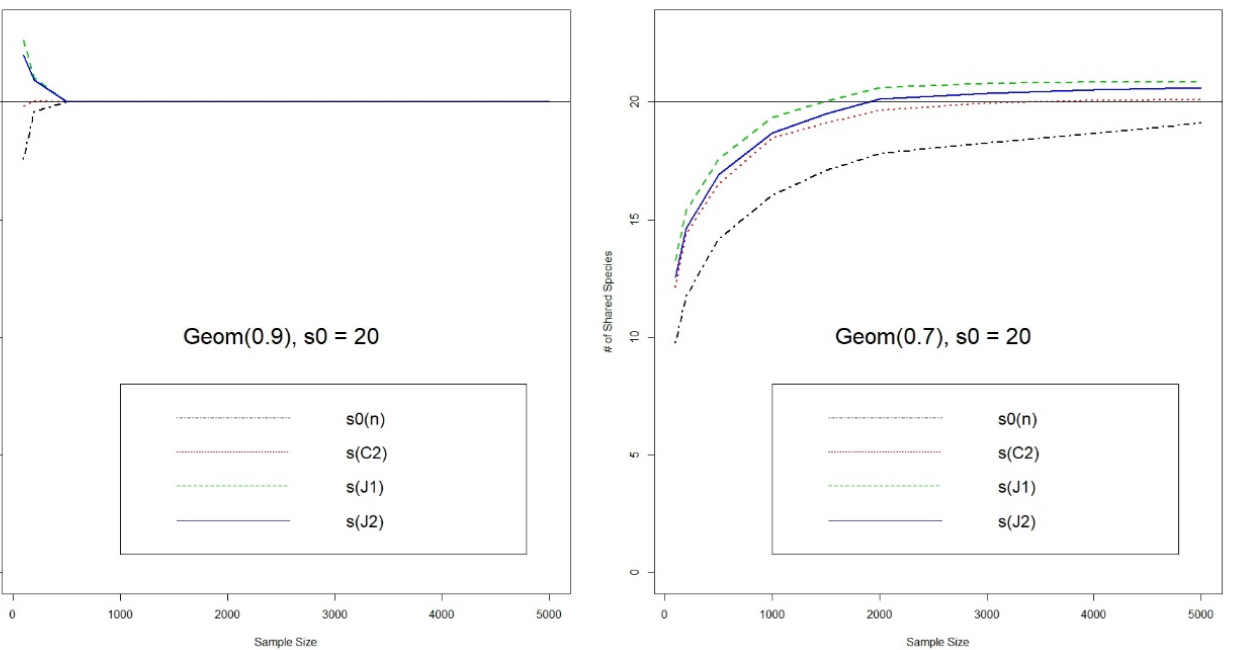
Figure 1. Estimates for the Number of Shared Species (Numbers of species in two populations are s 1 = 100 & s 2 = 100, and the number of shared species is s 0 = 20; J 1 & J 2: 1st & 2nd Jackknife estimates, C 2: Chao’s estimate, s 0 ( n ): number of observed shared species).